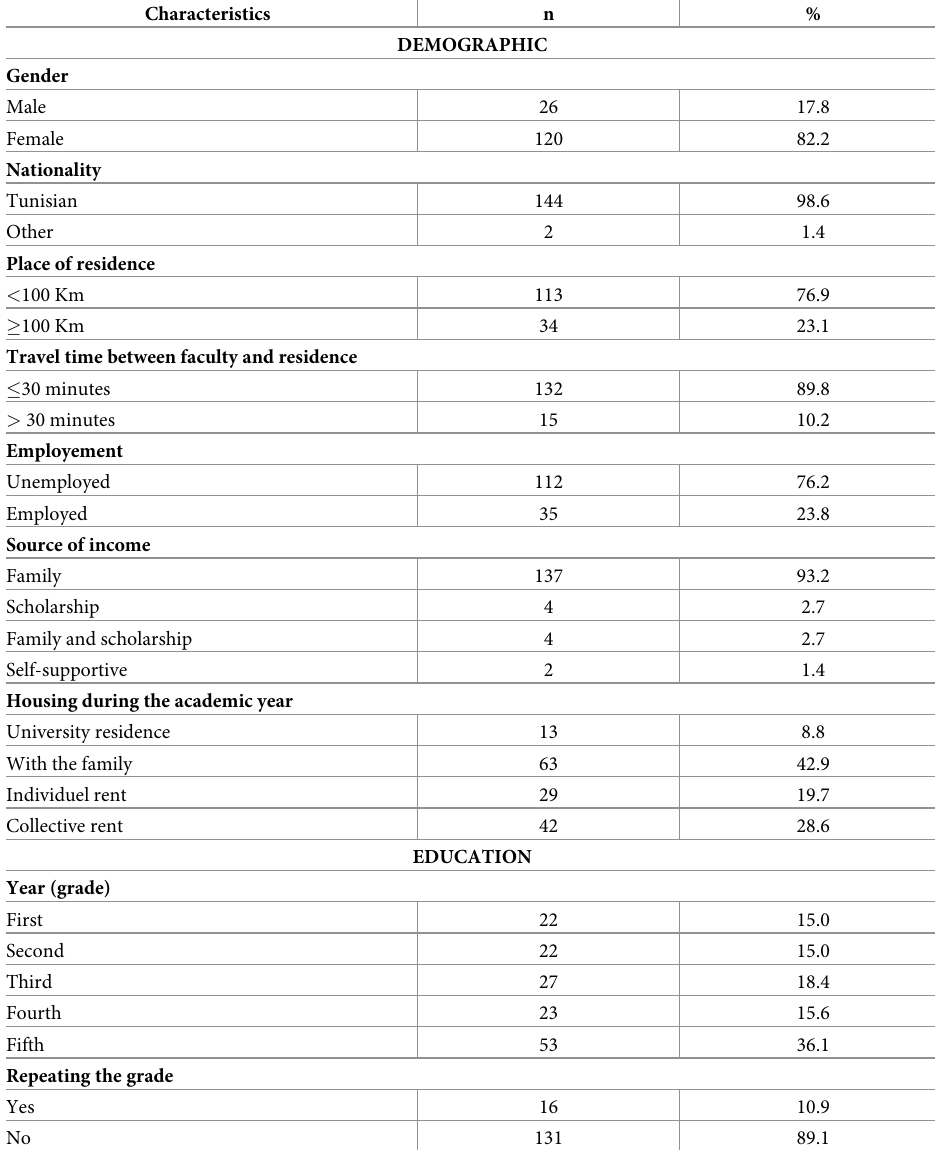
Table 1. Distibution of demographic characteristics of medical students, Sousse, Tunisia,